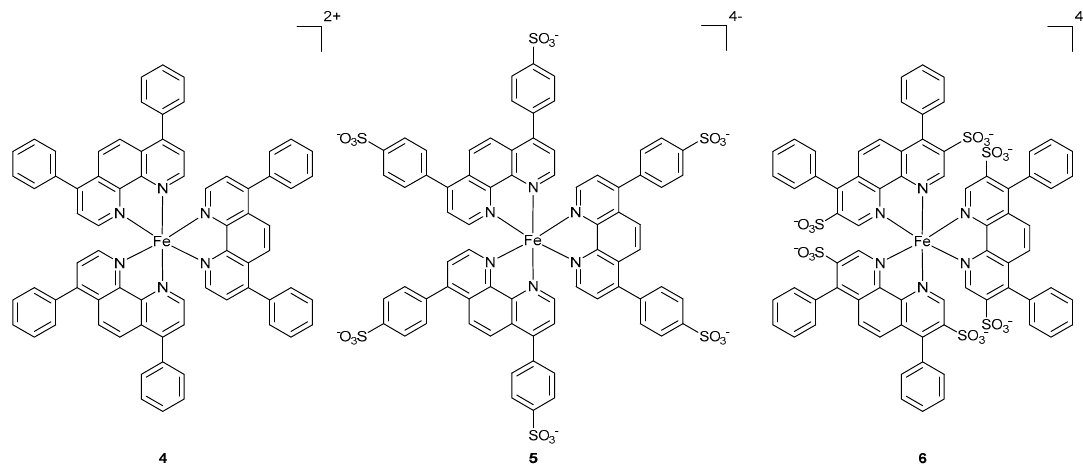
Figure 2. Chemical structures of the Fe(II) complexes investigated in this work. Complexes 4 was isolated as a PF 6 salt and the complexes 5 and 6 were isolated as Na salts.